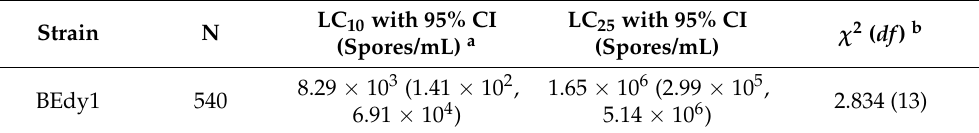
Table 1. The sublethal concentrations of Beauveria bassiana BEdy1 to the 3rd-instar nymphs of Soga- tella furcifera .